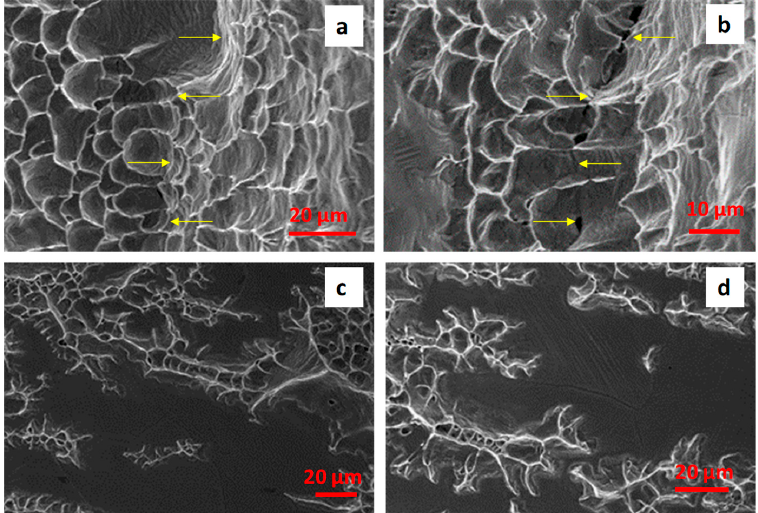
Figure 8. Bonding strength of the Cu-Cu bond in relation to the bonding duration (processing at 935 °C). Metals 2019 , 9 , x FOR PEER REVIEW